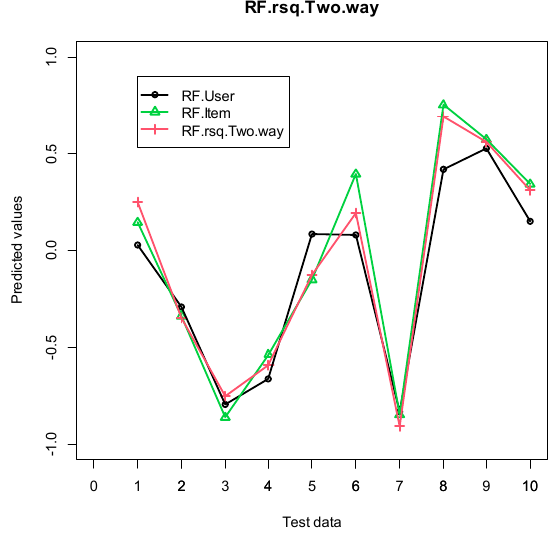
Figure 3. Predicted values for the RF R-square-based score.